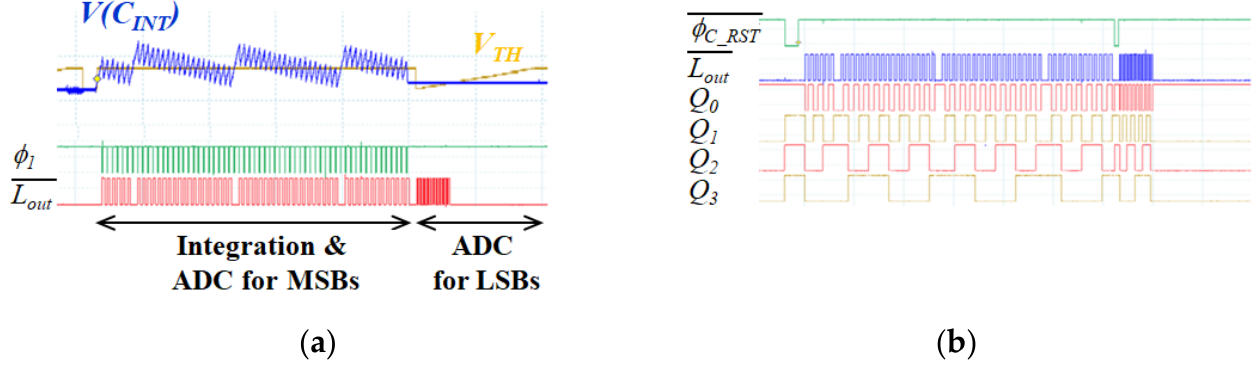
Figure 7. Measured operating waveforms of the proposed pixel-level ADC: ( a ) current integration and A/D conversion; ( b ) counter output.